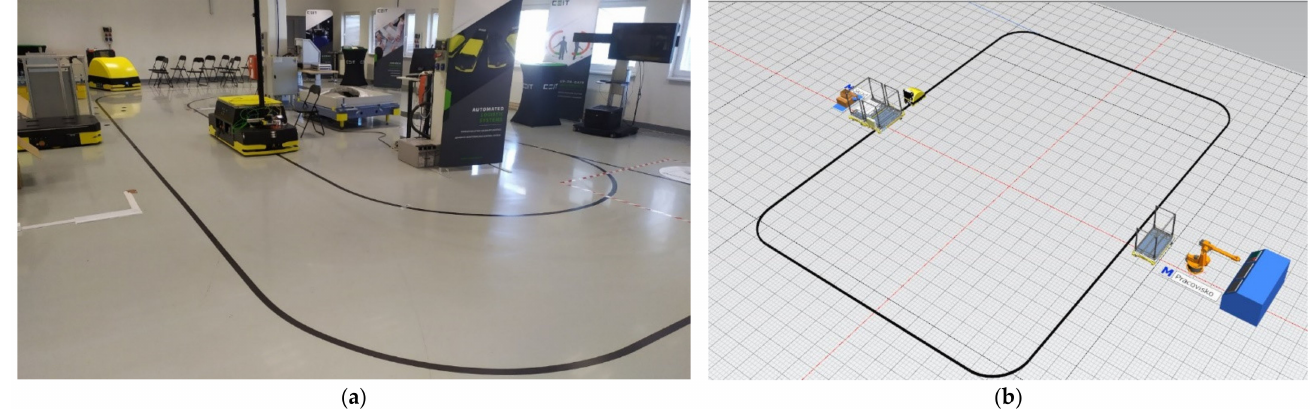
Figure 10. Illustration: ( a ) physical test site; ( b ) simulation-software-created testing centre.